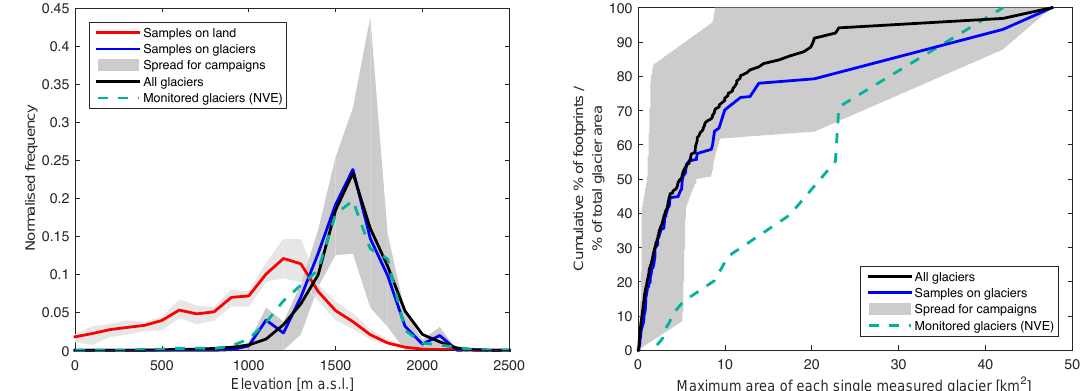
Figure 3. Representativeness of 2003–2008 ICESat autumn campaign samples in terms of footprint elevation (left) and area of glaciers sampled (right), compared to the entire glacierized surface in southern Norway and monitored glacierized surface (mass balance program by NVE). The grey spread encompasses the distributions of single ICESat autumn campaigns; where it is wide, the difference between individual campaigns is the largest. Reading example for glacier area comparison: 50% of the entire glacierized surface in southern Norway is made out of glaciers < 5km 2 , 50% of the glacierized surface where NVE runs a mass balance program is made of glaciers < 23km 2 , and 50% of all ICESat autumn ice samples lie on glaciers < 5.1km 2